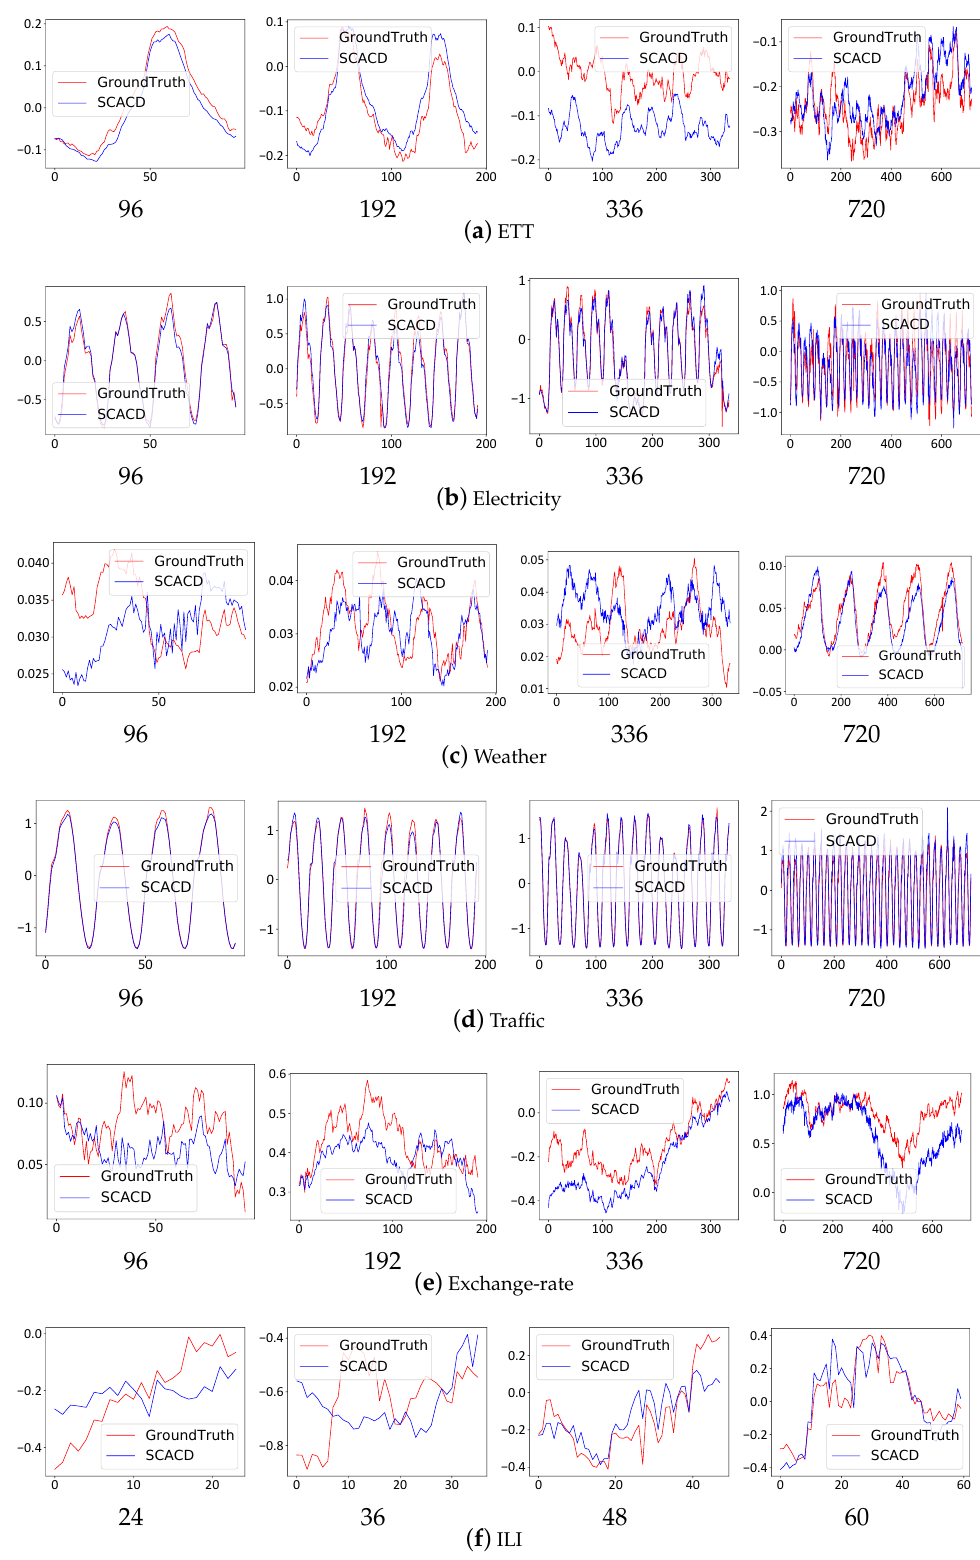
Figure A1. The forecasting curves of the six datasets.